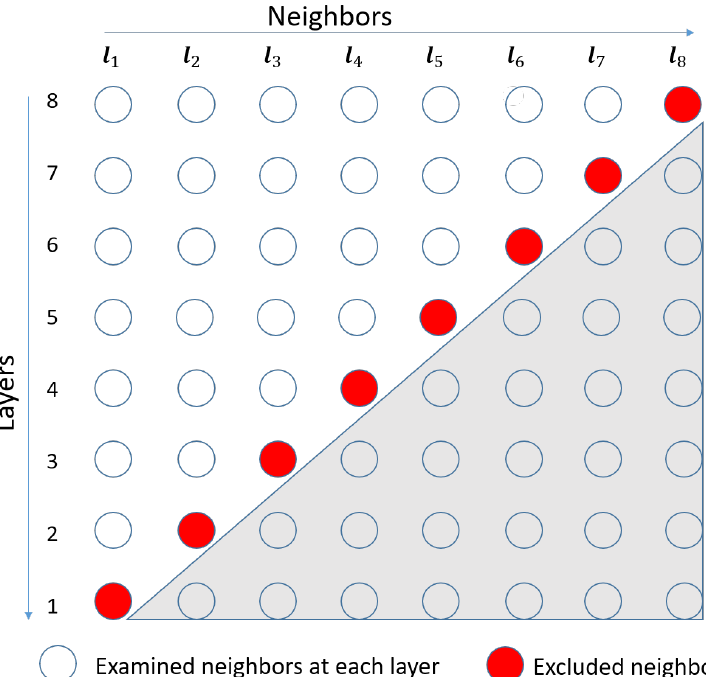
Figure 1. The ENR operation for k = 1 and L =